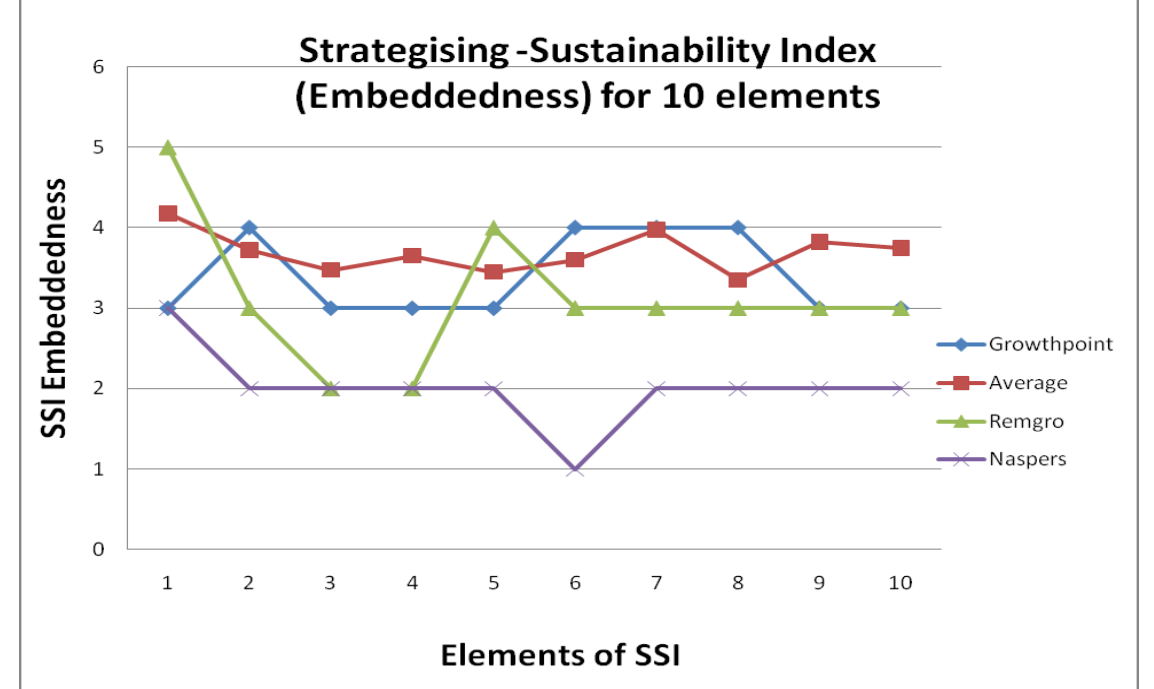
Table 4: Comparison of SSI elements based on different criteria whereby groups were analysed on SSI index and Market